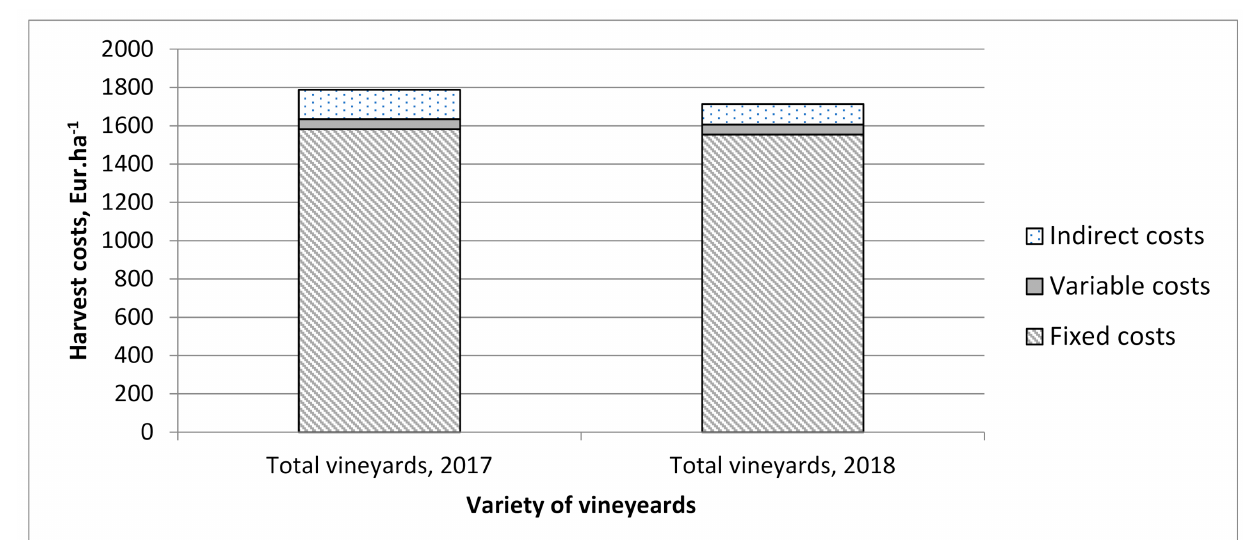
Figure 3. Harvesting costs (Fixed, variable, and indirect) for total vineyards, year 2017 and